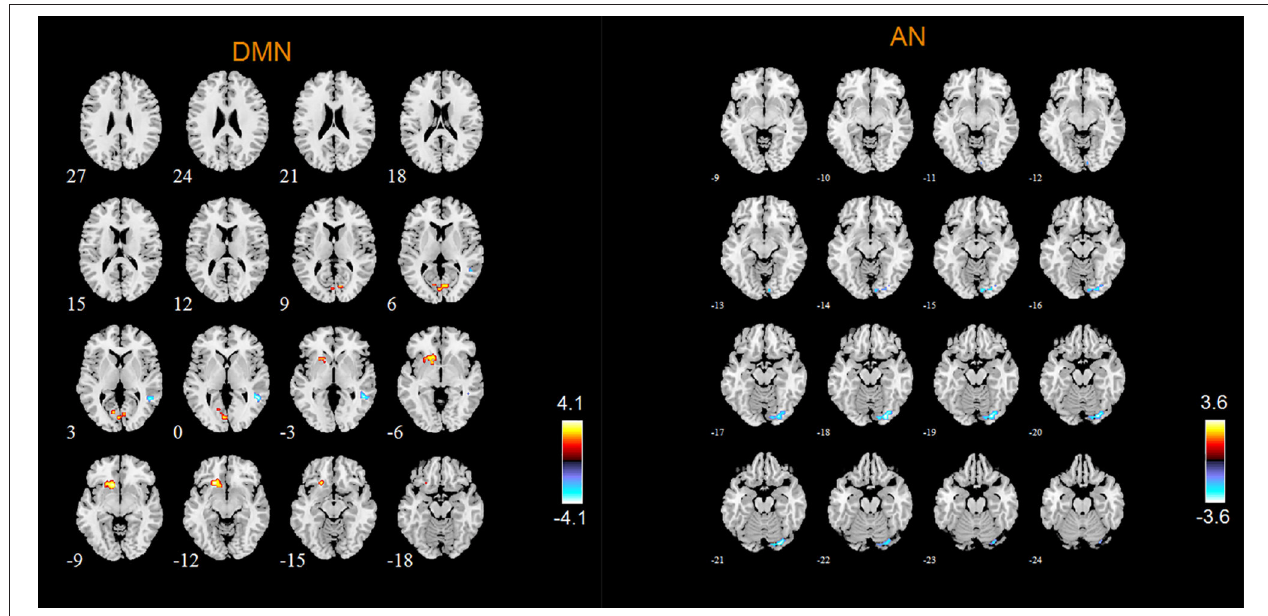
FIGURE 4 | Abnormal brain regions in the DMN, AN,